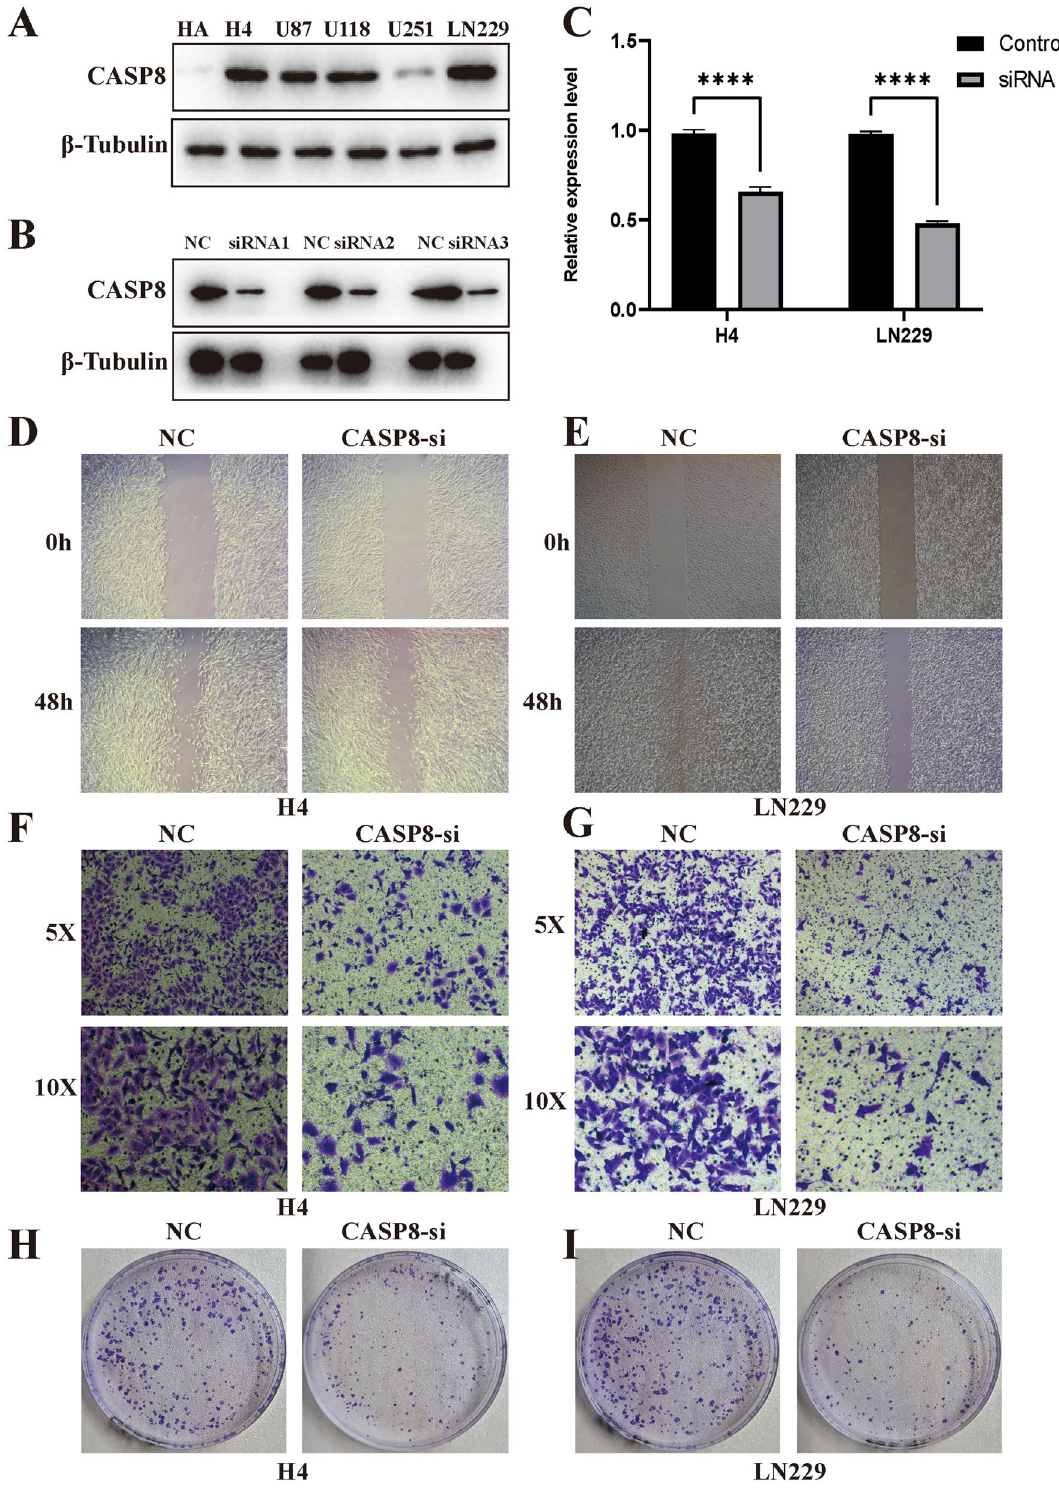
Figure 10. CASP8 promotes progression of glioma cells. ( A ) Expression levels of CASP8 in glioma cell lines. ( B ) The western blot of CASP2 in U87, LN229, H4 cell lines after siRNA. ( C ) The mRNA expression level of CSAP8 in H4 and LN229 after siRNA. ( D , E ) CASP8 silencing inhibited migration of glioma cells. ( F , G ) CASP8 silencing inhibited invasion of glioma cells. ( H , I ) CASP8 silencing inhibited growth of glioma